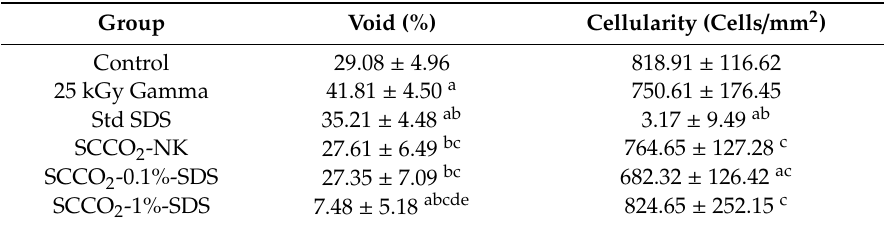
Table 3. Void percentage and cellularity across